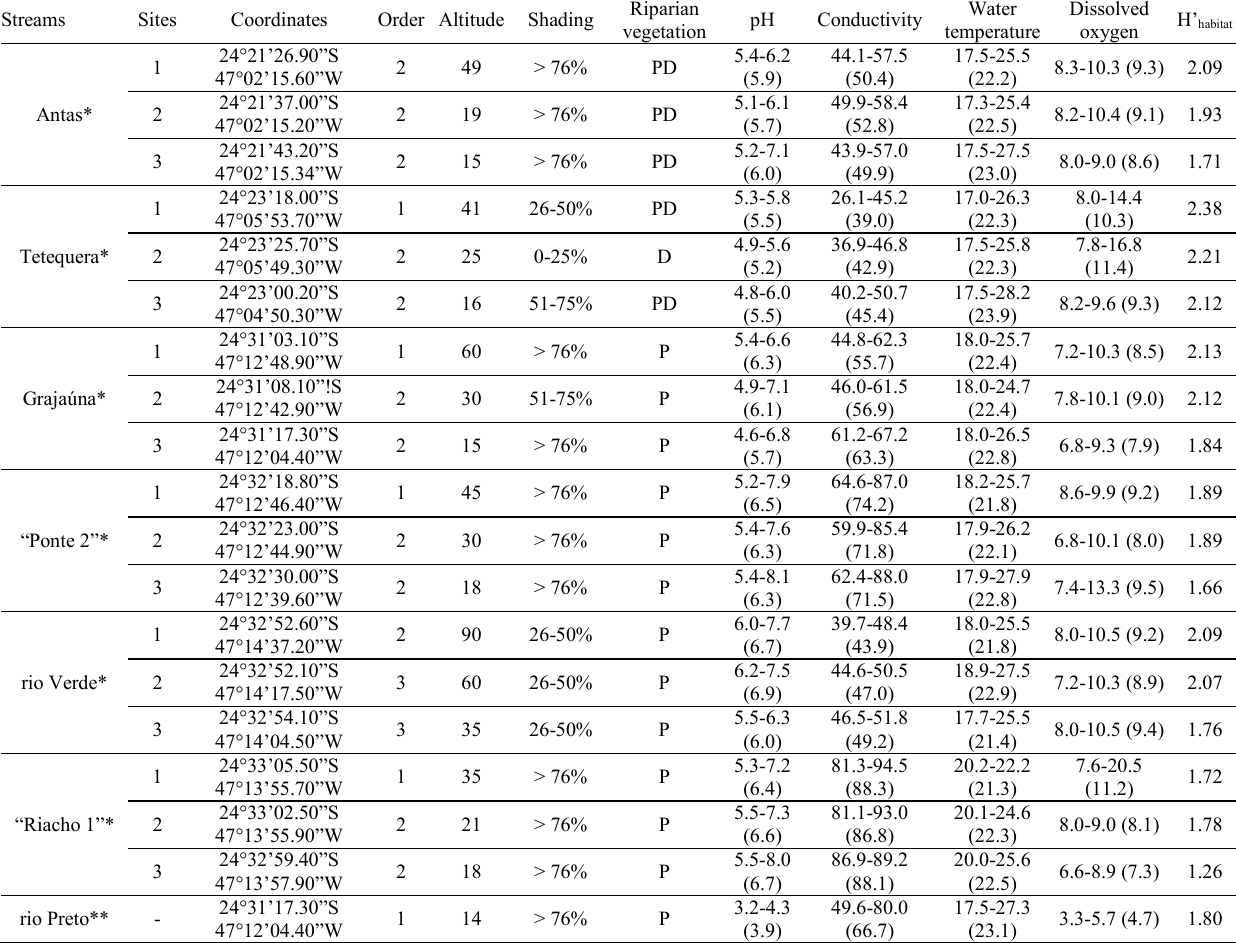
Table 1. Description of the sampled sites in Jureia-Itatins Ecological Station, indicating the clear (*) and blackwaters (**) streams, geographic location, channel order (scale 1:50,000), altitude (m), shading and state of preservation of riparian vegetation (P: preserved, PD: partially deforested, D: deforested). Range and average (in parentheses) values of pH, conductivity ( μ S.cm -1 ), water temperature (°C), dissolved oxygen (mg.L -1 ), and Shannon diversity index considering habitat structure (H’ sampled site, between April 2009 and February 2010. Upper (site 1), middle (site 2) and lower (site 3) stream stretches. Measures of habitat structure were taken during June